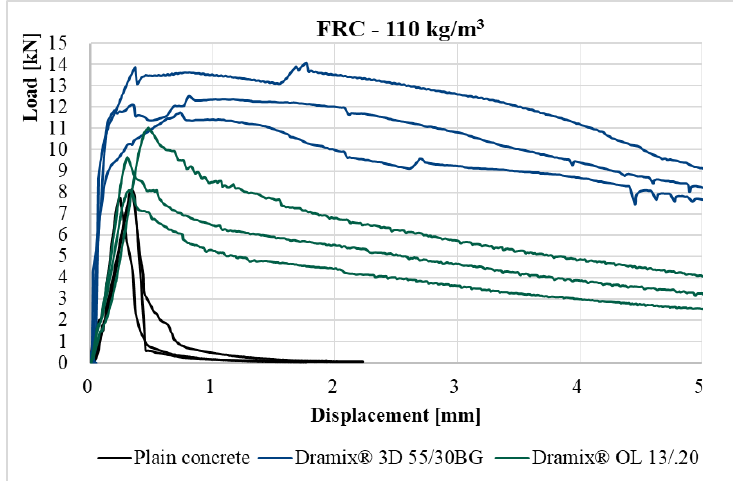
Figure 15. Load–displacement diagrams for plain concrete and fiber-reinforced concrete with fiber dosage of 110 kg/m 3 .